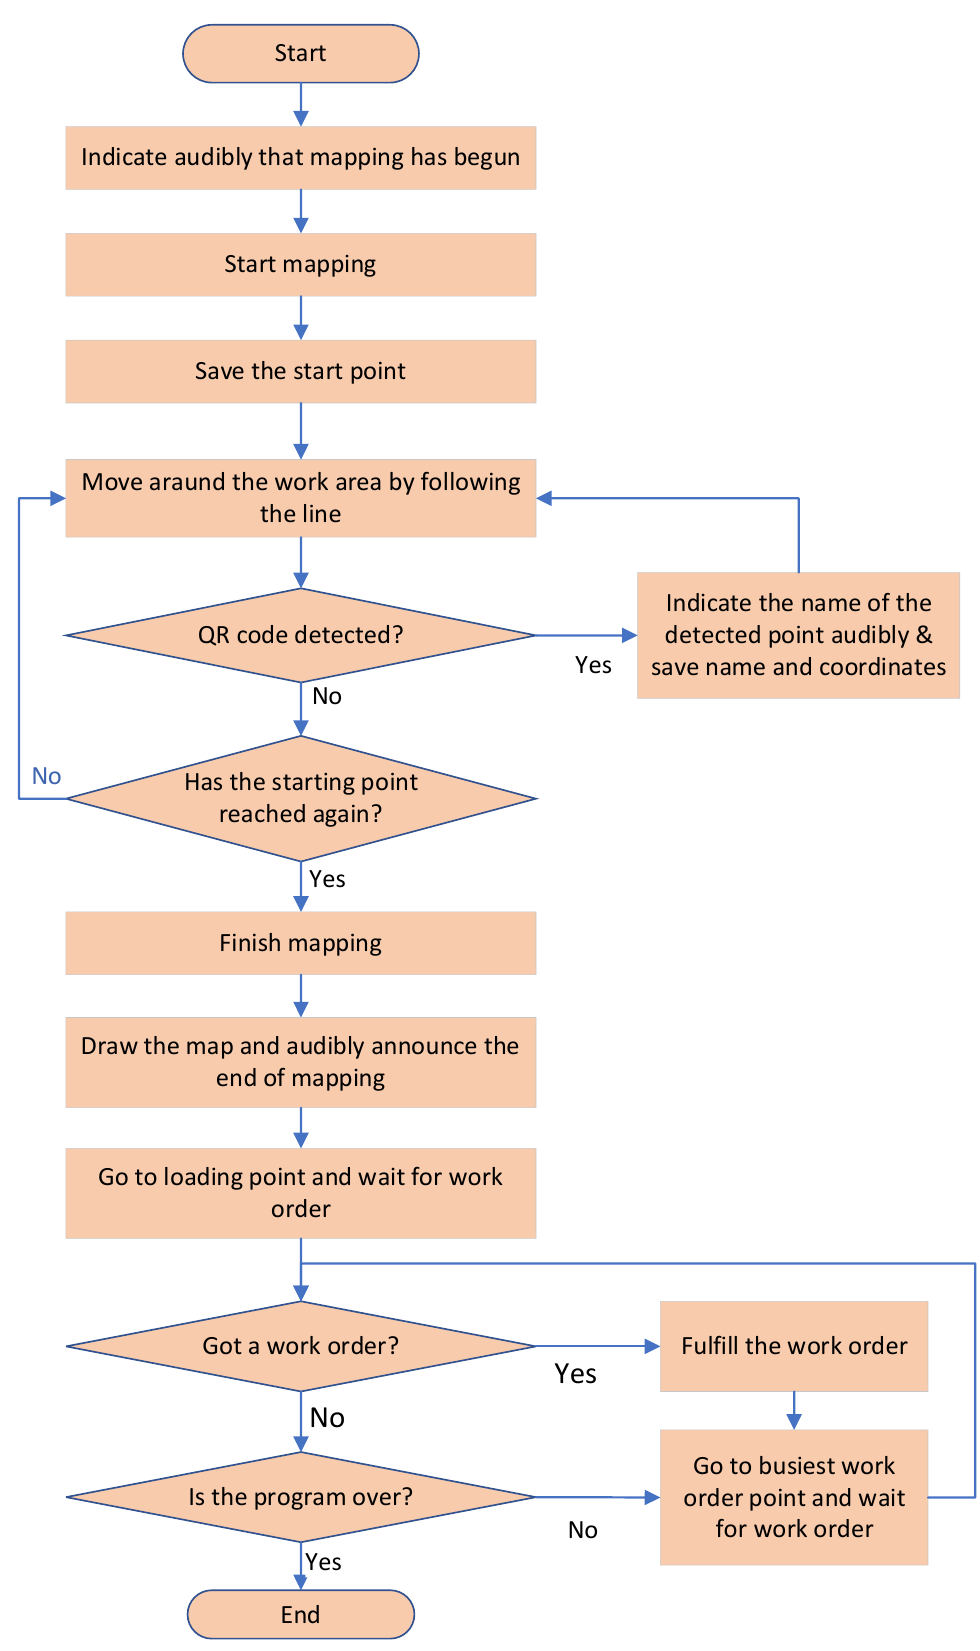
Figure 7. Flowchart of the main algorithm.